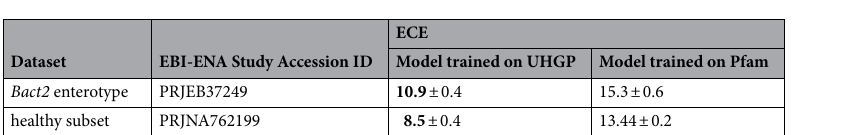
Table 1. Results from metagenomic validation of the trained models. Exponential Cross-Entropy (ECE) measures how good the model is at the training task, which is predicting the next or the previous amino acid in a protein sequence. More detailed results can be found in Supplementary Tables 1 and